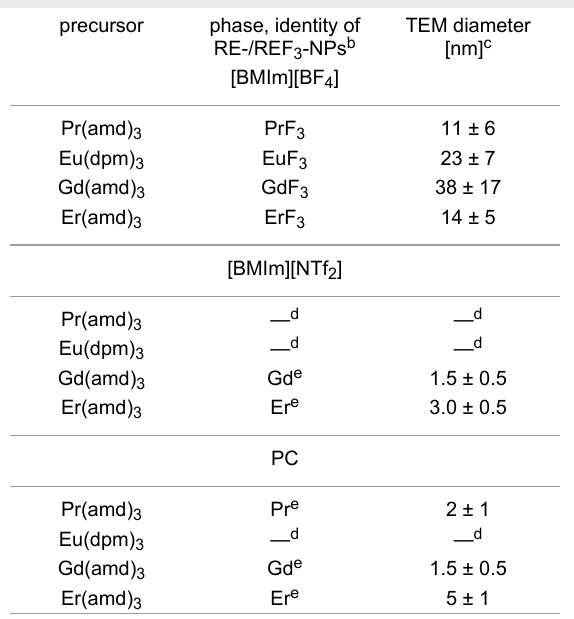
REF -NPs from RE(amd) 3